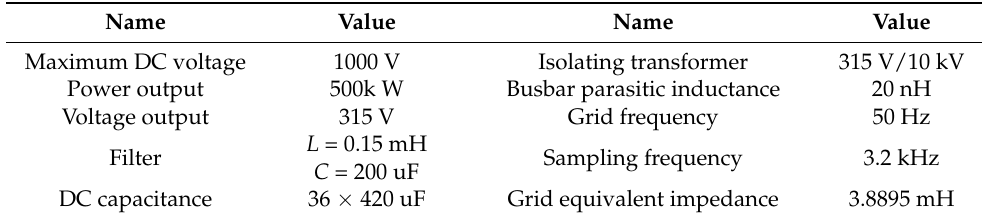
Table 1. Electrical parameters of Huawei SUN2000 PV